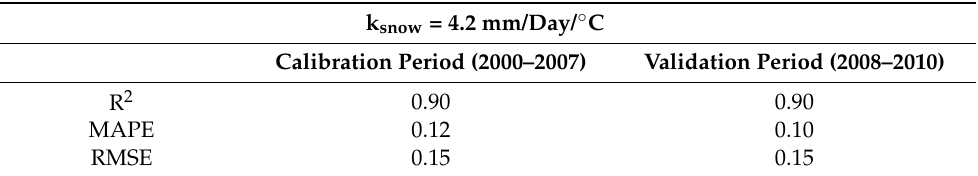
Table 3. Statistical measurements for the accuracy of the temperature index snow model’s results that predicted snowmelt and snow fractions during the calibration (2000–2007) and validation (2008)